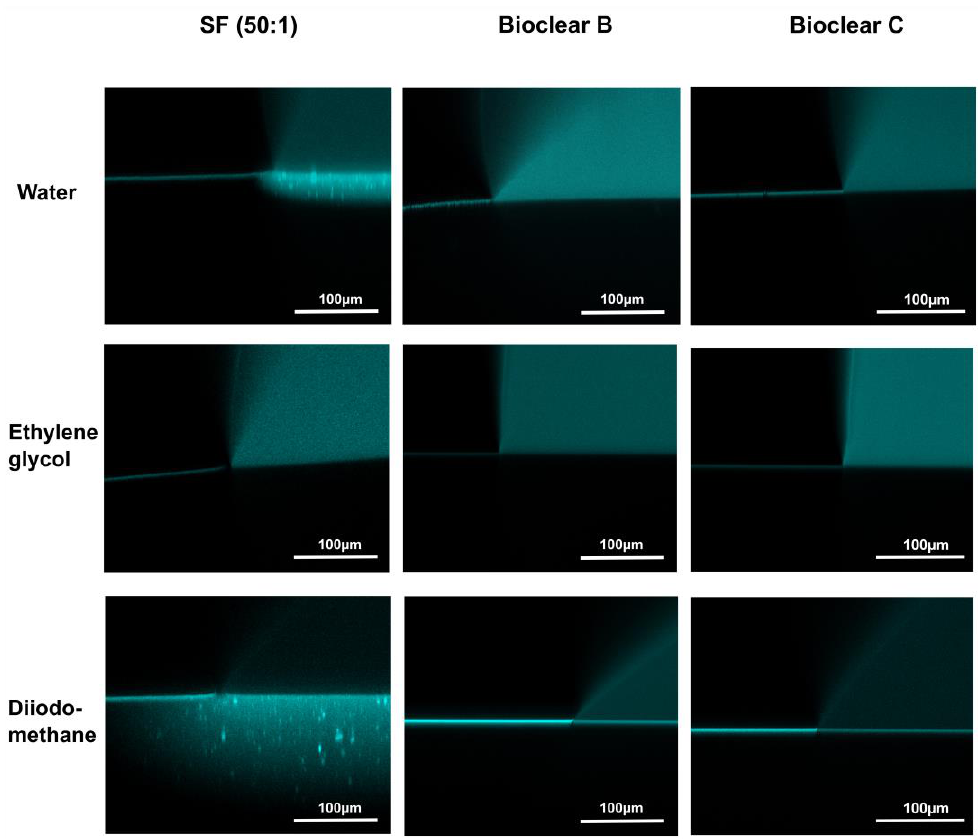
Figure 2. Confocal microscopy images of the three-phase contact line area of 5 µL droplets of water, ethylene glycol, and diiodomethane on soft PDMS types SF and Bioclear B and C. Droplets were dyed with rhodamine B to increase visibility. Water and diiodomethane diffuse into the soft SF surface as indicated by the bright halo underneath the droplet. On Bioclear, no diffusion of fluids is observed.